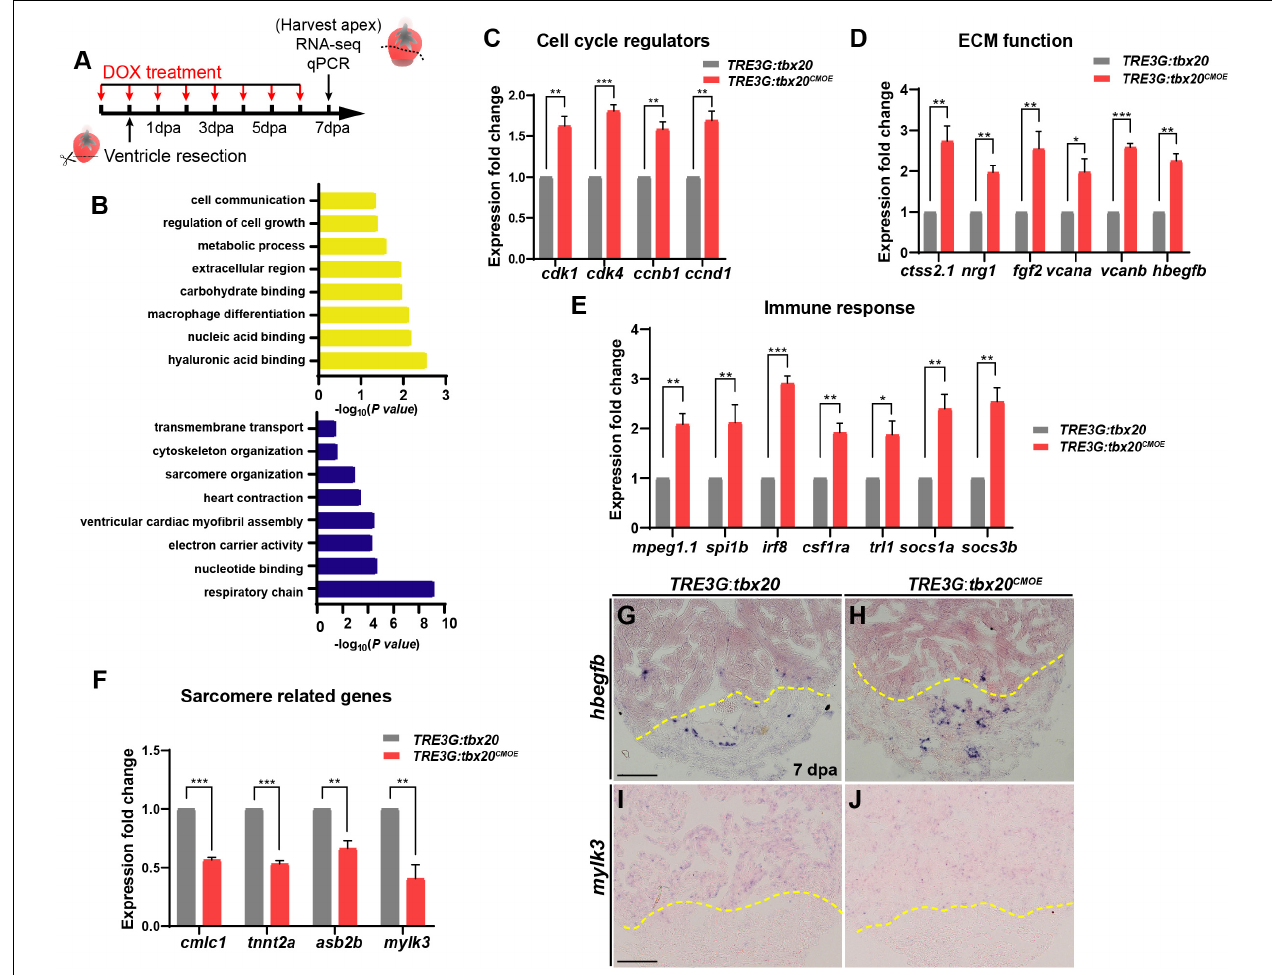
FIGURE 4 | Myocardial tbx20 overexpression affects expression of various injury responsive genes following heart injury. (A) Schematic of DOX treatment, heart injury and tissue collection procedures. RNA samples were extracted from the ventricular apices (below the dashed line). For each group, 6–8 samples were collected, and three independent biological replicates were carried out. (B) Significantly enriched gene ontology (GO) analysis based on RNA-seq results revealed upregulated gene categories (upper panel), and downregulated gene categories (lower panel). (C–F) Bar graphs indicate qPCR analyses of relative expression levels of genes associated with “Cell cycle regulators” (C) , “ECM function” (D) , “Immune response” (E) and “Sarcomere related genes” (F) in ventricular apices from DOX-treated Tg ( TRE3G:tbx20 CMOE ) and Tg ( TRE3G:tbx20 ) at 7 dpa. Data represents three biological replicates. Mean ± SEM, * p < 0.05, ** p < 0.01, *** p < 0.001. (G–J) Representative images of ISH analyses for hbegfb (G,H) and mylk3 (I,J) on 7 dpa heart sections from Tg ( TRE3G:tbx20 CMOE ) and Tg ( TRE3G:tbx20 ) zebrafish with DOX treatment.Scale bar: 100 µ